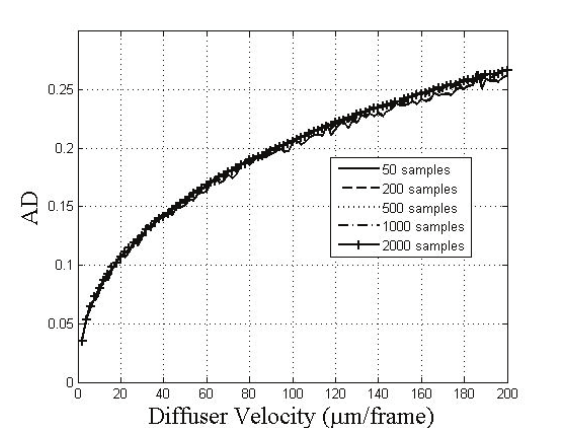
Fig. 14 Subtraction Average descriptor ( SA )